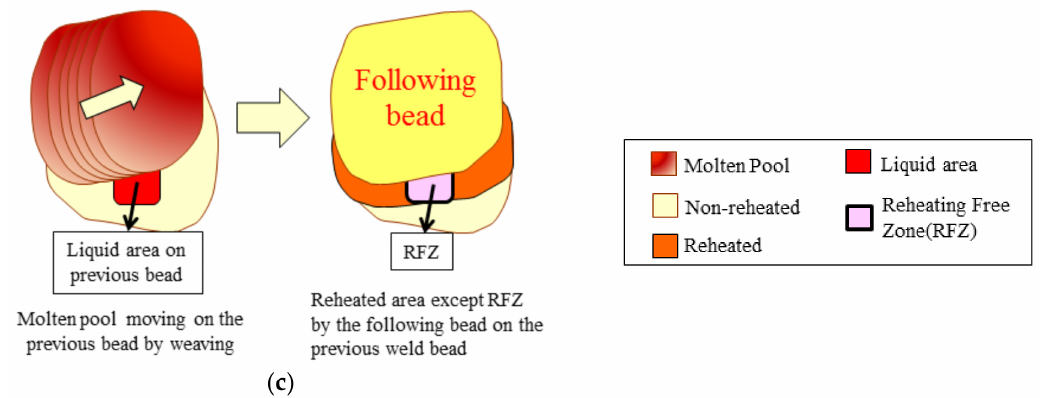
Figure 12. Schematic diagram of the non-reheated area, reheated area and reheating-free zone; ( a ) non-reheated area; ( b ) reheated area; and ( c ) reheating-free zone.